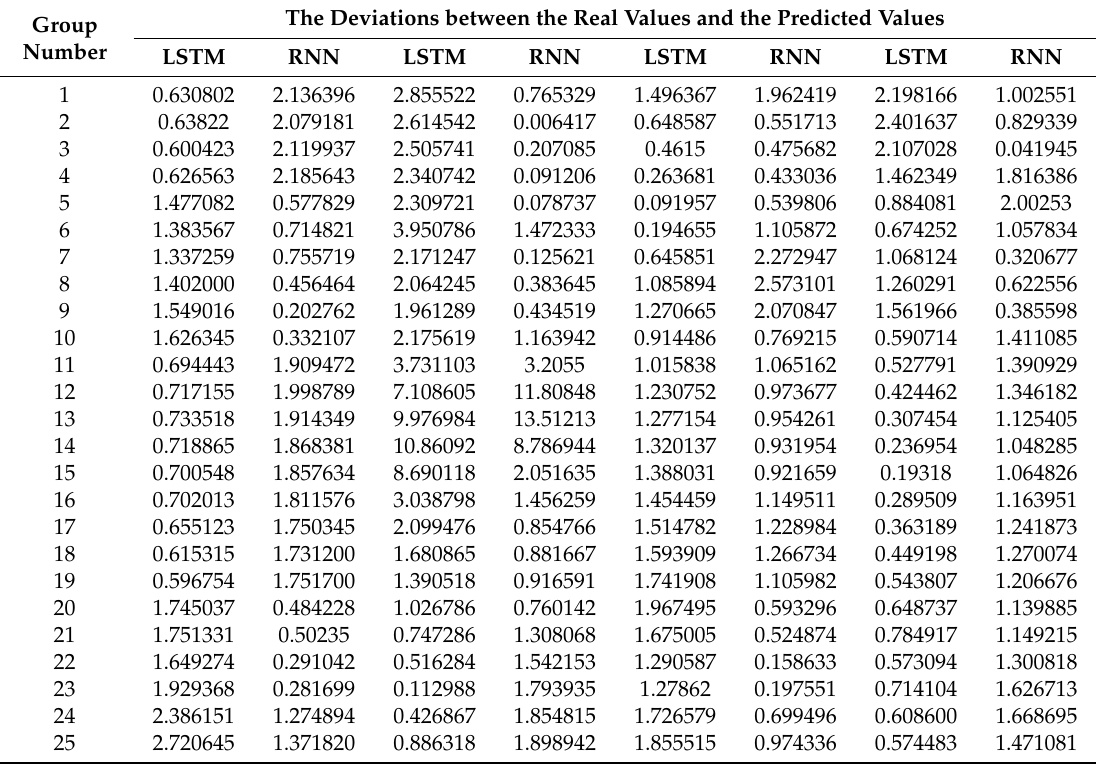
Table 5. Deviations between the predicted values and the real values using RNN and LSTM.